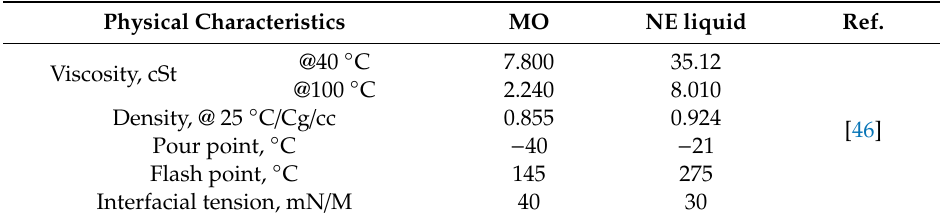
Table 6. Evaluation of physical characteristics of natural esters (NEs) and MO.